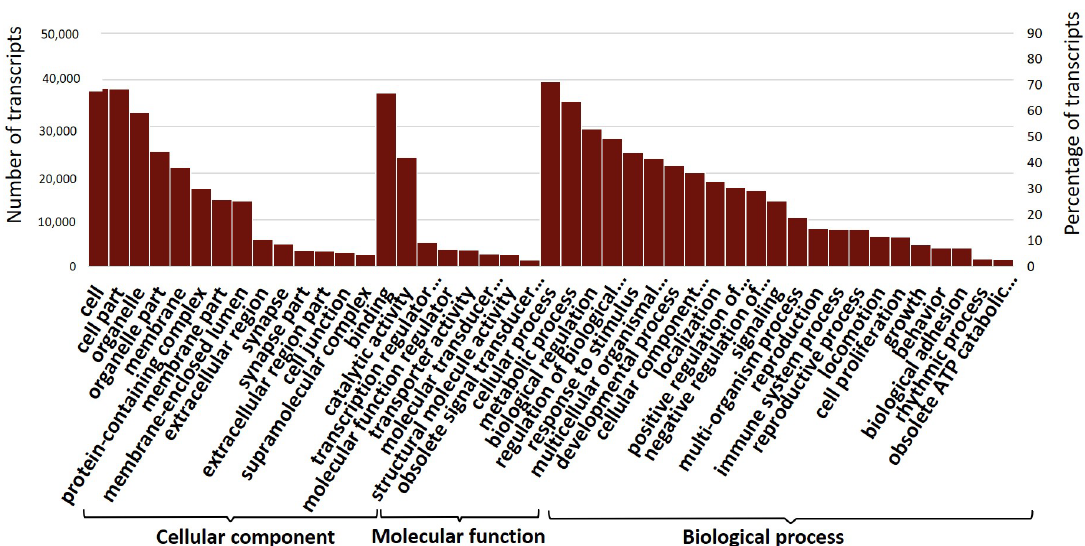
Figure 4. GO classification. Distribution of level 2 GO terms with transcripts percentage more than 1 were visualised using the Web Gene Ontology Annotation Plot (WEGO) web tool. Results are summarised in three main categories: biological process, cellular component, and molecular function. The left axis shows the number of transcripts, while the right axis shows the percentage of transcripts. GO, gene ontology.